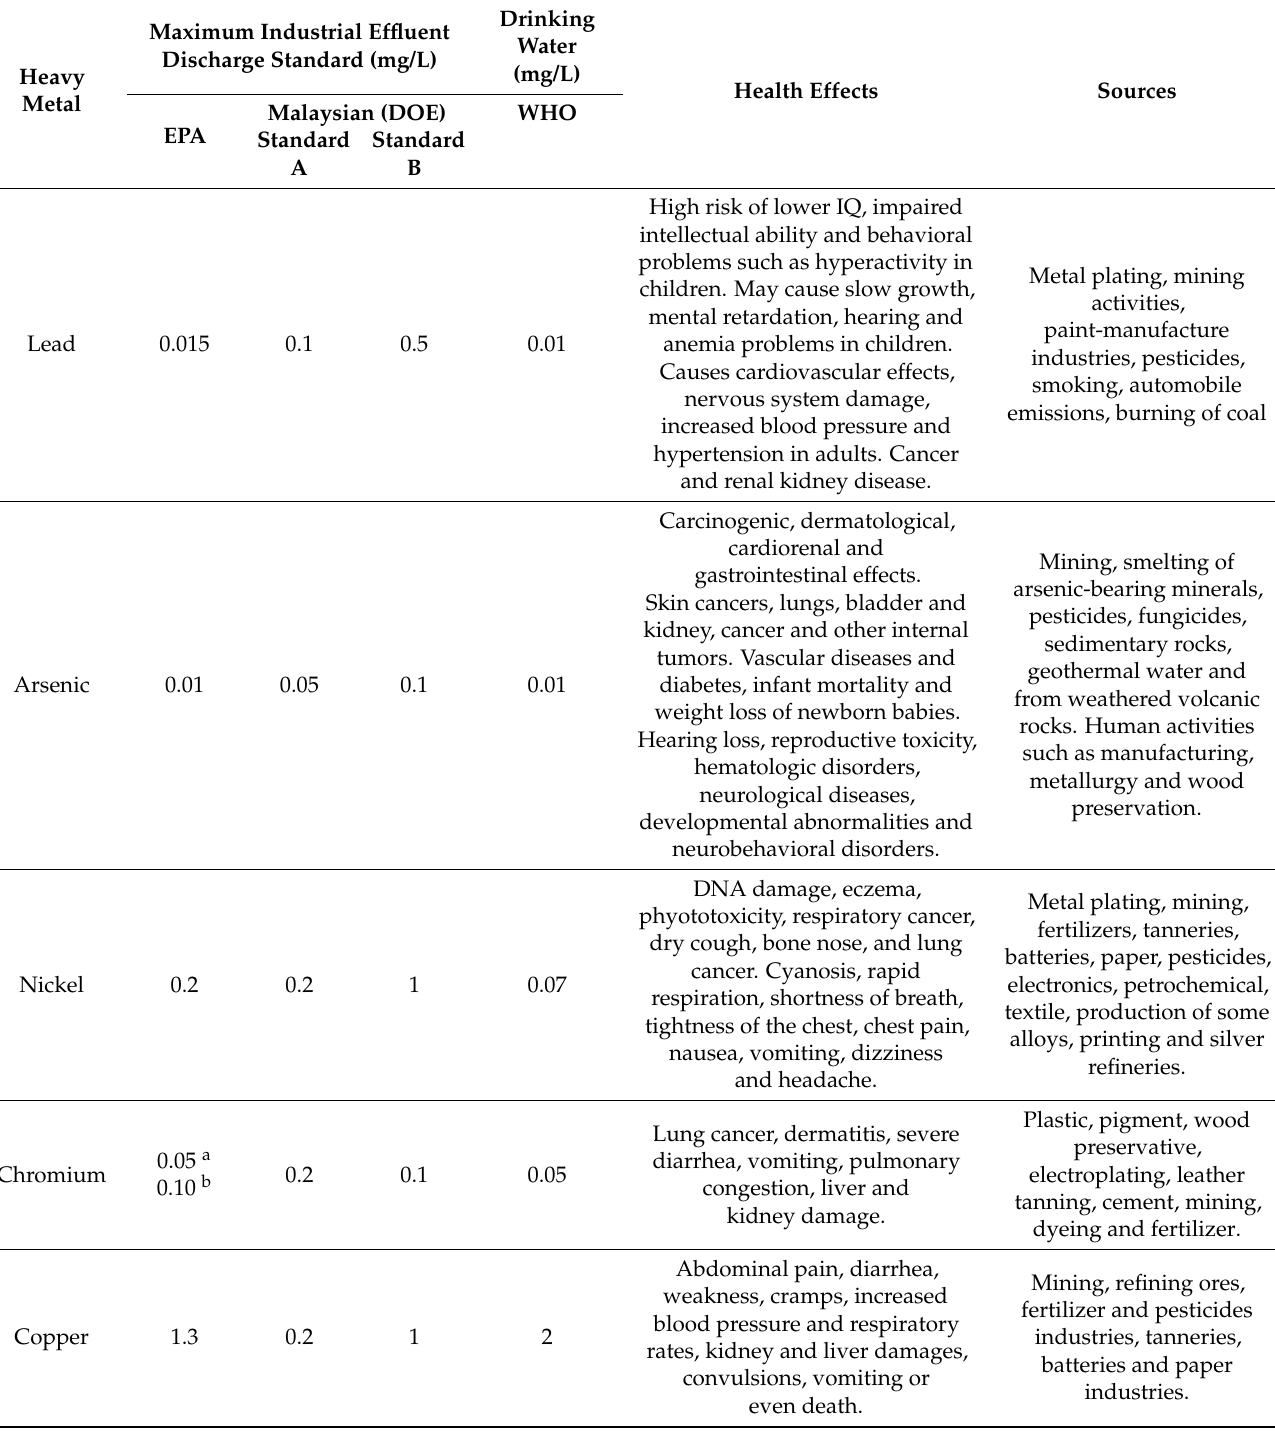
Table 1. Discharge limits and health effects of heavy metals